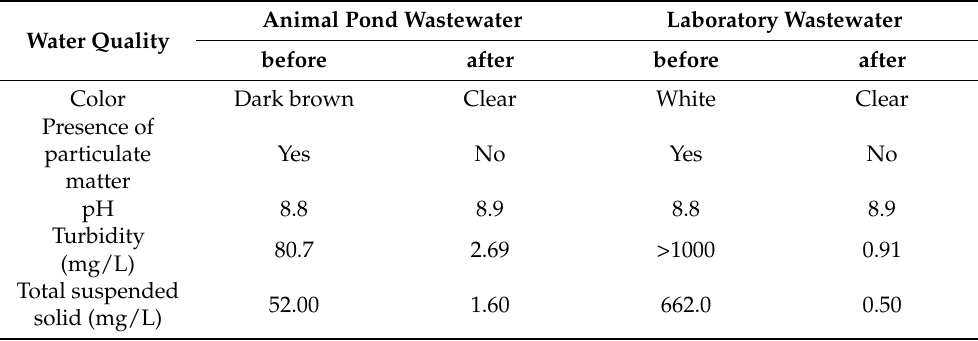
Table 2. Water analysis of wastewater before and after filtration using monoliths prepared using template-directed porous